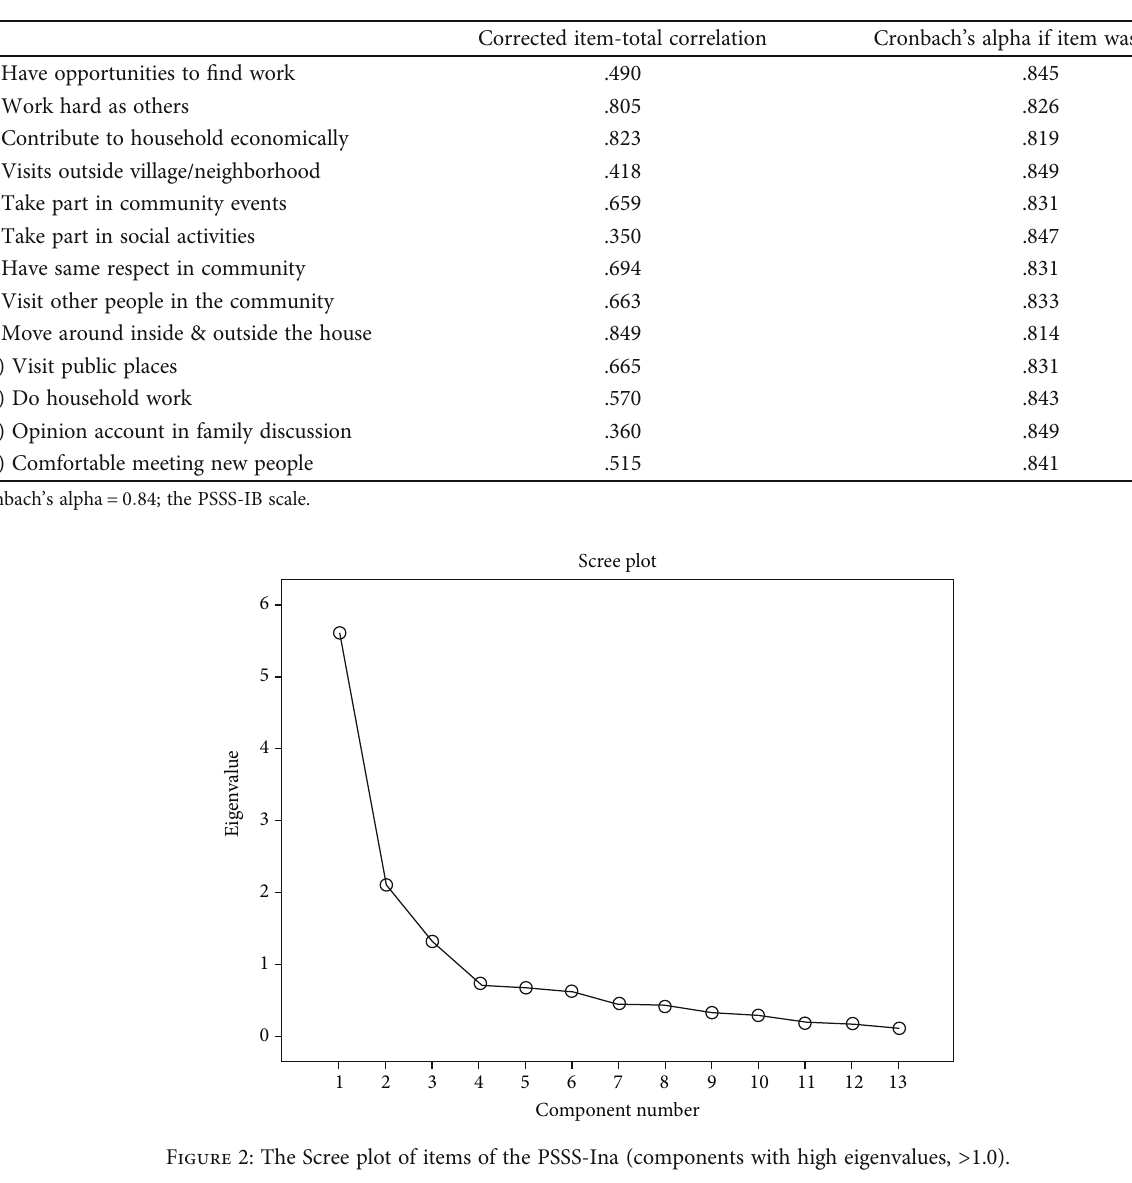
Table 2: The item-total correlations of the